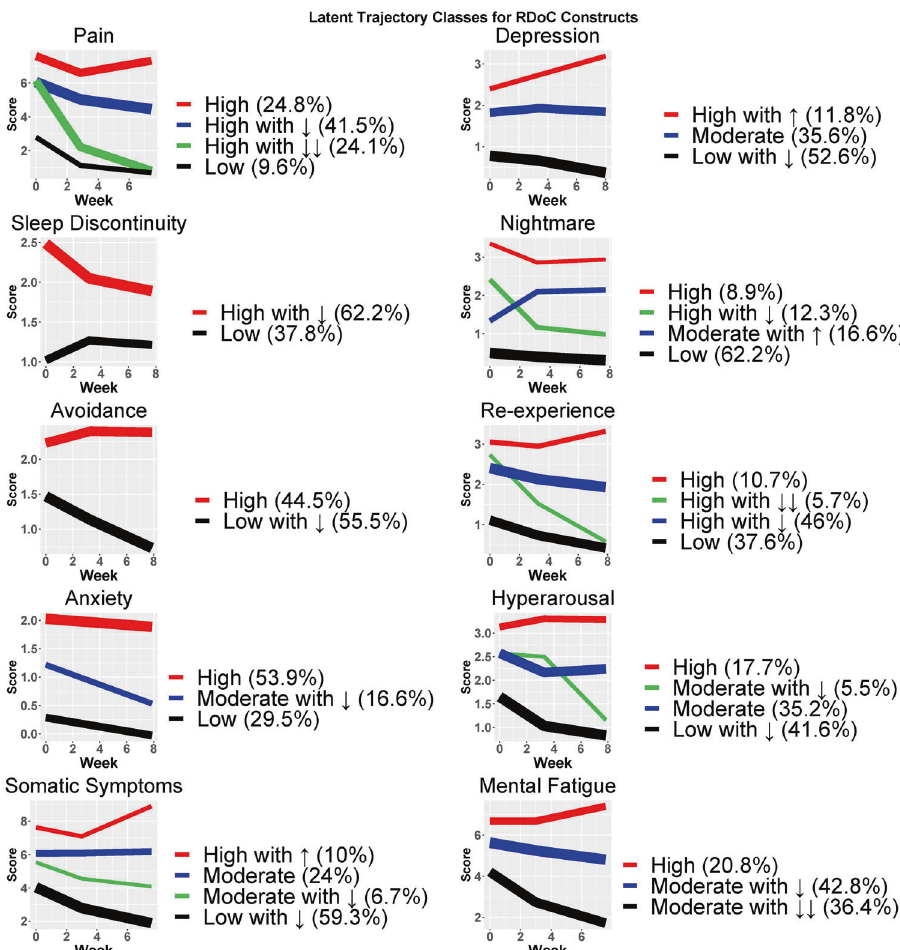
Fig. 1 Common posttraumatic symptom trajectories during the eight weeks after motor vehicle collision (MVC). Common trajectories within each symptom domain were identi fi ed using latent growth curve mixture models developed from measurement models created using serial assessments of each symptom domain. (Each domain assessed six times in the fi rst eight weeks after MVC.) Percentages within the legend for each symptom domain represent the percentage of trauma survivors within each latent class. The thickness of the lines represents the proportion of participants in each latent cluster. ↓ : decreasing over time, ↓↓ : major decrease over time, ↑ : increasing over